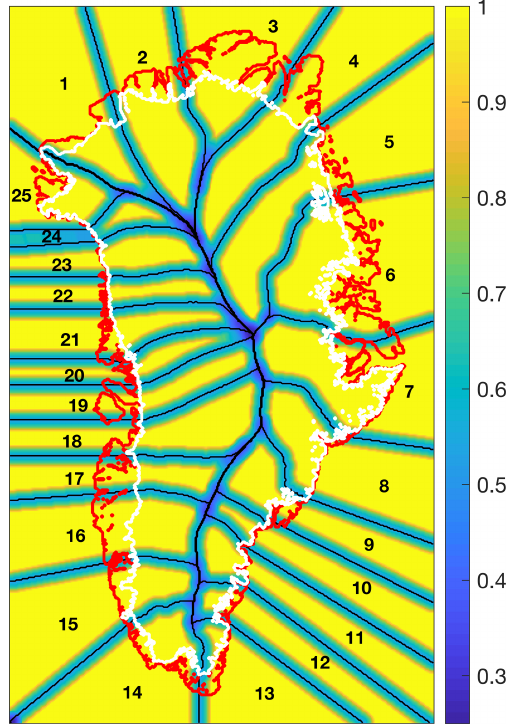
Figure 4. Weighting factor of the local basin for remapping. The local weighting factor increases from the basin divides (black lines) to 1.0 in the centre over a specified distance (here 50km), while the factor for the neighbouring basin decreases proportionally (not shown). The white contour outlines the ice sheet margin and the red line the Greenland